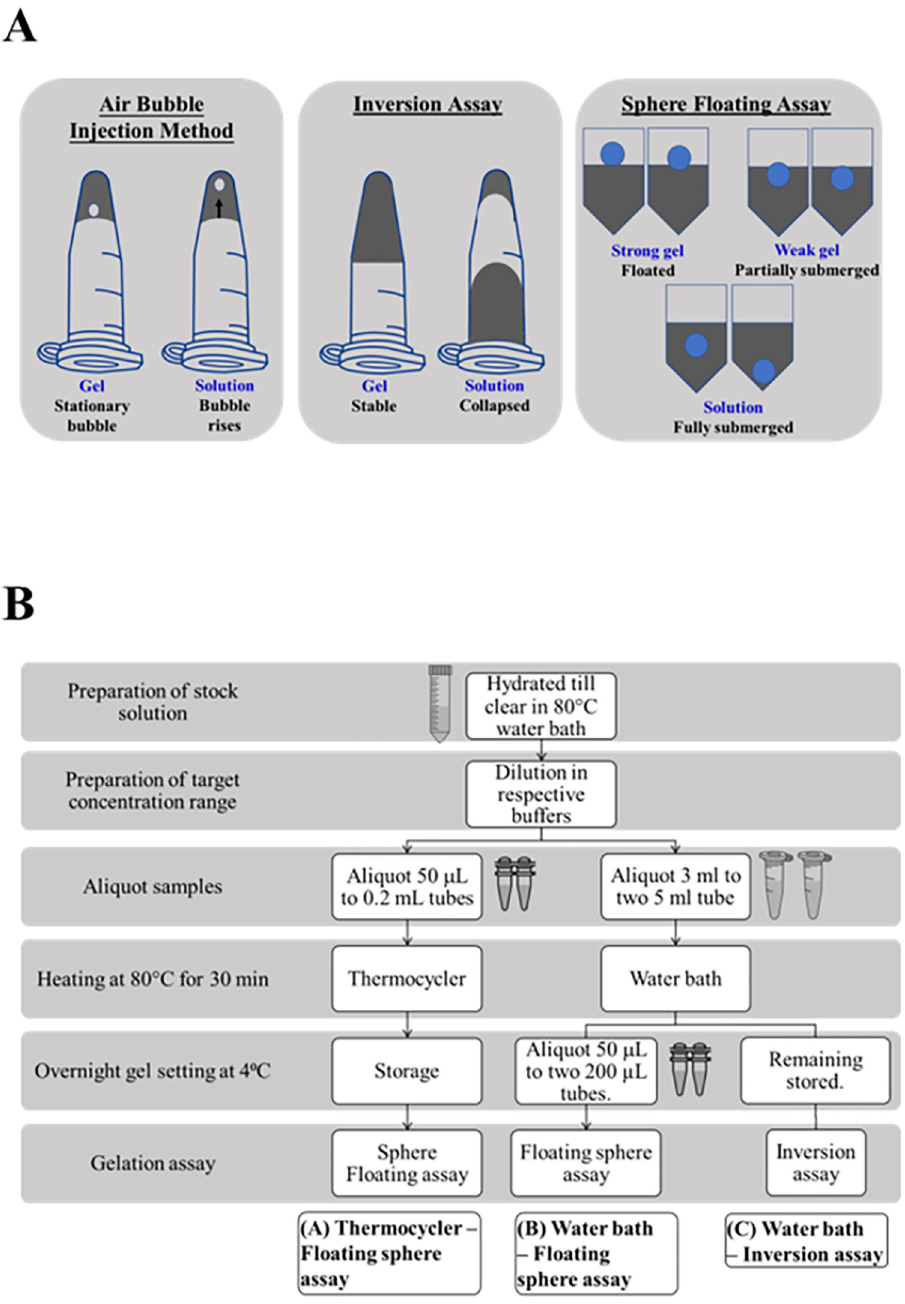
Fig 1. Floating sphere assay for assessing gelation. (A) Comparison of the proposed Floating Sphere Assay against conventional approaches. (B) Outline of the experimental strategy for Floating Sphere Assay. resembling that of collagen. Around three regions of the helix generally interact. These regions transit from intra to inter-helix at higher concentrations, forming junction zones that induce gelation [13]. In contrast, gellan and κ carrageenan are linear anionic polysaccharides. Gellan comprises of tetrasaccharide repeats of [ ! 3)- β -D- glucose-(1 ! 4)- β -D-glucuronic acid